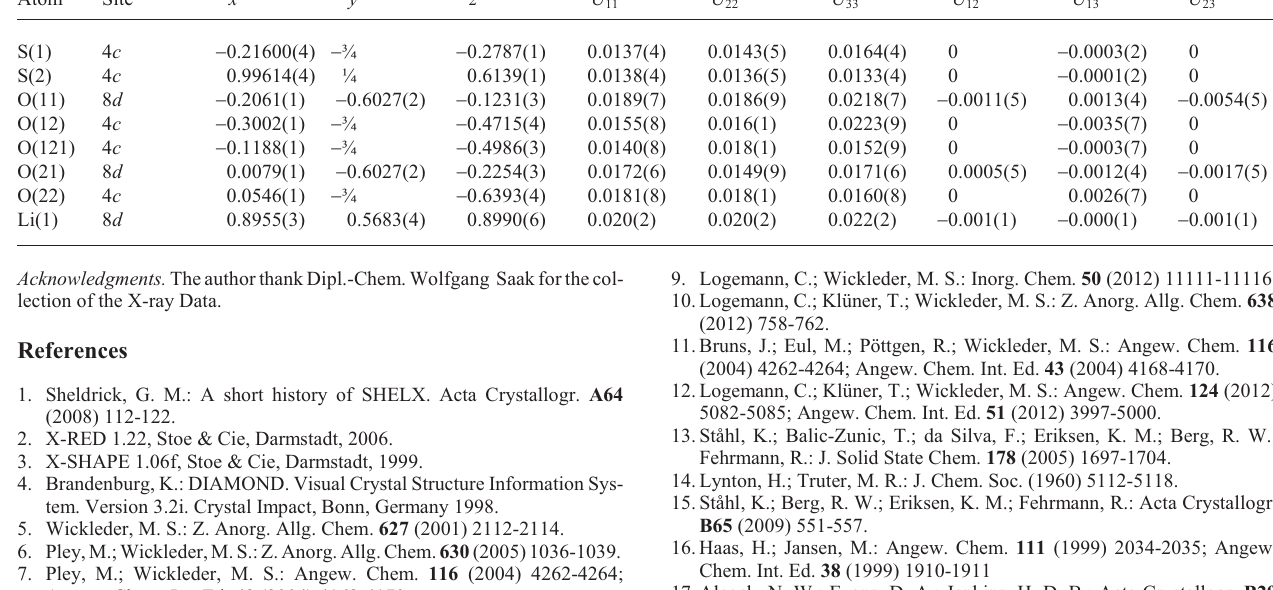
Table 2. Atomic coordinates and anisotropic displacement parameters (in Å 2 ) .